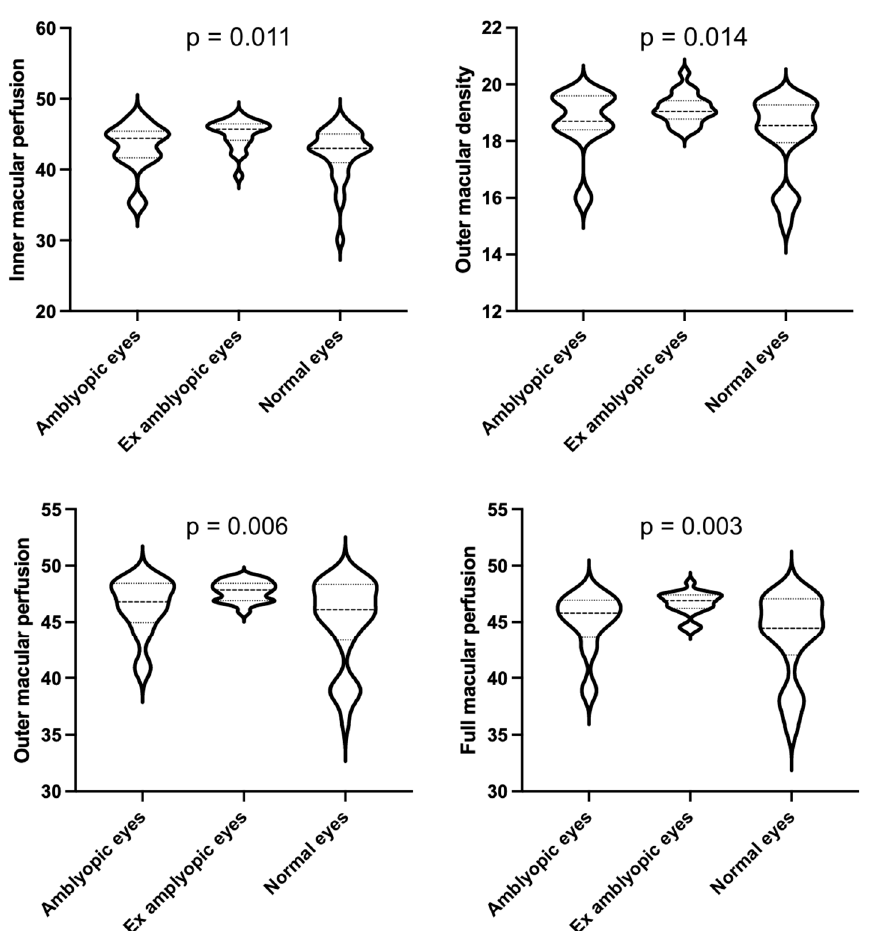
Figure 2. Violin plots illustrating OCT ‐ A parameters statistically significantly differing in ex am ‐ blyopic eyes compared to amblyopic and normal eyes. All OCT ‐ A parameters are expressed in percentage. p values are shown in the upper side of each graph.